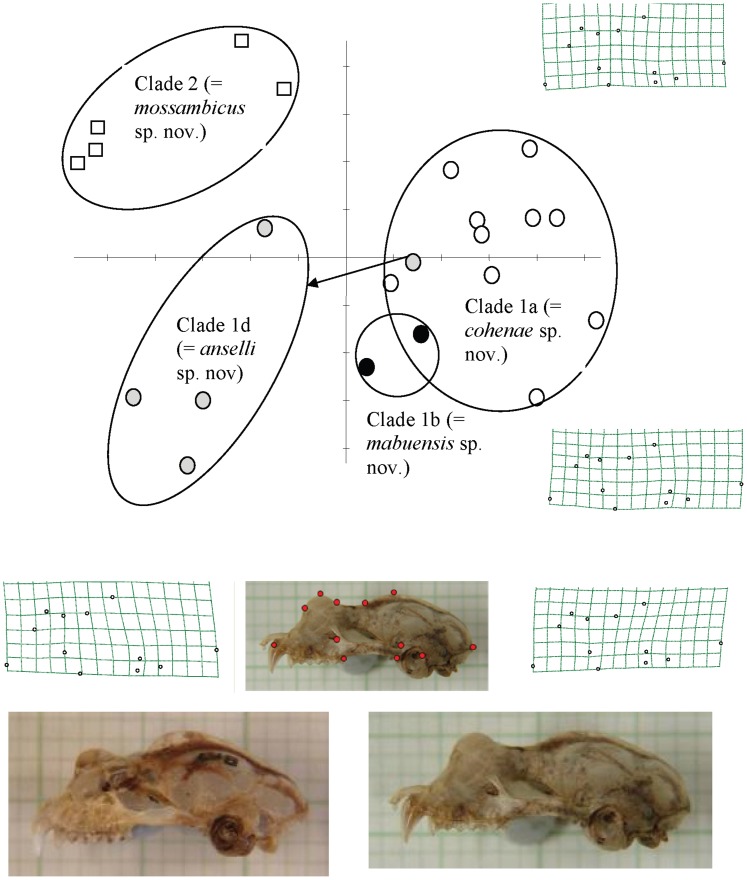
Relative warps analysis (RWA) of 12 lateral cranial landmarks from 23 individuals of R. hildebrandtii s.l. belonging to two molecular clades and two lineages of Clade 1 (see
Fig. 3
).Revised taxon names are provided in parentheses (see Taxonomic Conclusions). Skulls which were included in this analysis are indicated in Table S1. Symbols as is in Fig. 5. Thin plate splines (grids) show landmark distortions represented by extremes of variation on RW1 (left = negative; right = positive) and RW2 (bottom = negative; top = positive) axes. The two skull photographs at the bottom are of actual specimens representing the negative (left: DM 8577, mossambicus from Namapa, Mozambique) and positive (right: DM 11560, cohenae from Mayo, Mpumalanga Province) extremes of variation on RW1. Landmark positions (filled circles) are shown in the photograph in the centre.